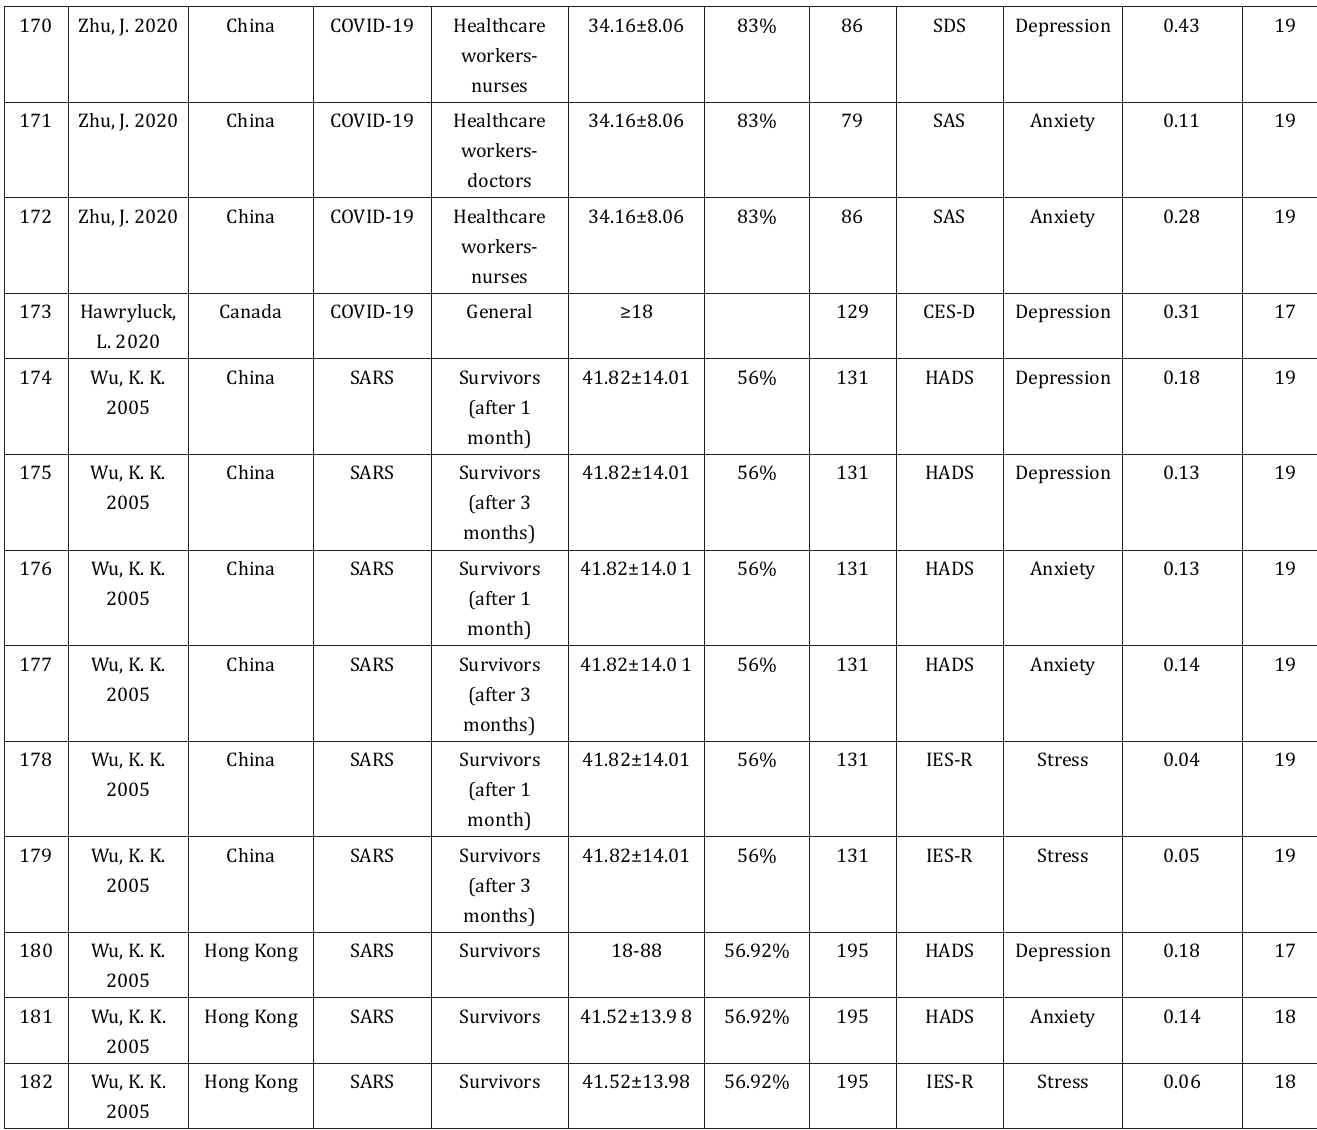
Meta-analyses using the DerSimonion-Laird random effect model revealed that pooled prevalence estimation of depression during the coronavirus epidemics was 24.8% (95% CI: 22% to 27%). Pooled prevalence estimation of depression sub-grouped by study population and different study tools are presented in Fig 3-A. The study population (p = 0.003), study tools (p = 0.068), and region of the study (p = 0.085) were responsible for 16.55% of the heterogeneity (Adjusted R squared “Adj R-squared” = 16.55%). Meta-regression in the correlation between different populations study (as the most important